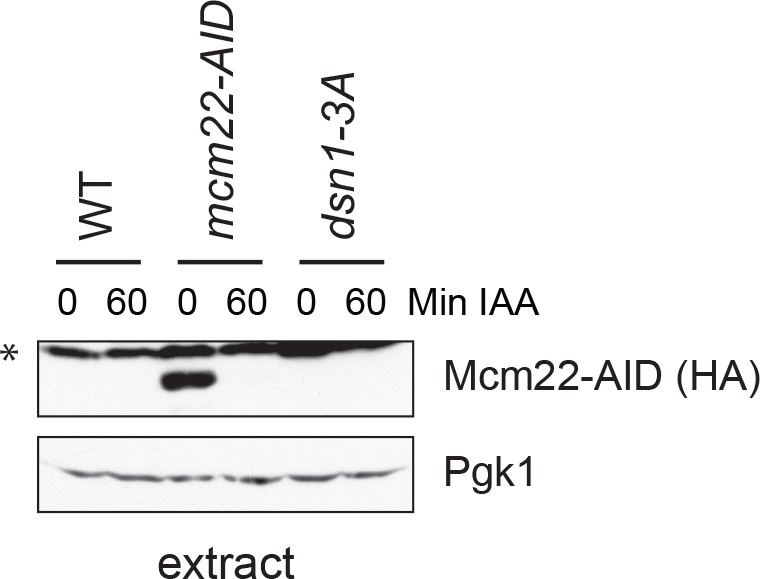
Mcm22-3HA-AID is efficiently degraded after 60 min of auxin treatment.The strains are DSN1-3Flag CNN1-3V5 OsTIR1 (SBY18040), DSN1-3Flag CNN1-3V5 mcm22-3HA-AID OsTIR1 (SBY18042), and dsn1-3A-3Flag CNN1-3V5 OsTIR1 (SBY18028).